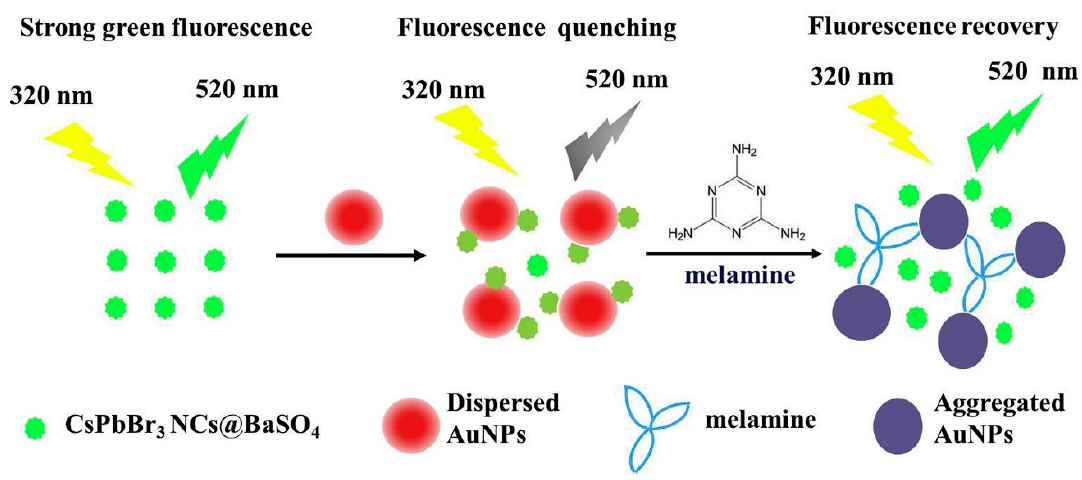
Figure 21. Schematic illustration of turn-on fluorescent melamine nanosensor based on the inner filter effect of the AuNPs on CsPbBr 3 NCs@BaSO 4 (reproduced with the permission from reference [200]).